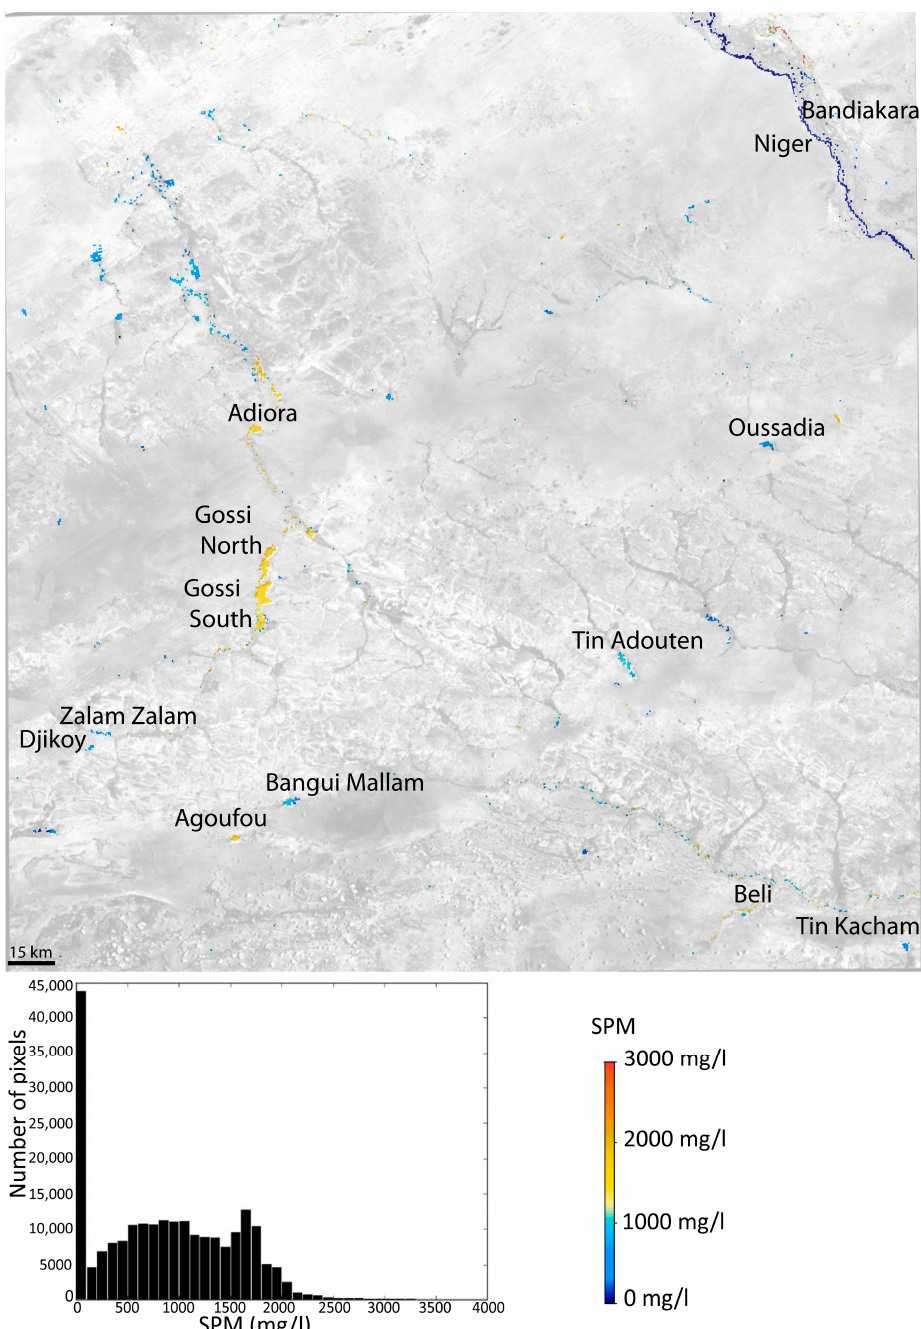
Figure 14. SPM values derived from the Landsat 8 image acquired on 24 August 2013 and histogram showing SPM values for all the pixels classified as water in the scene.